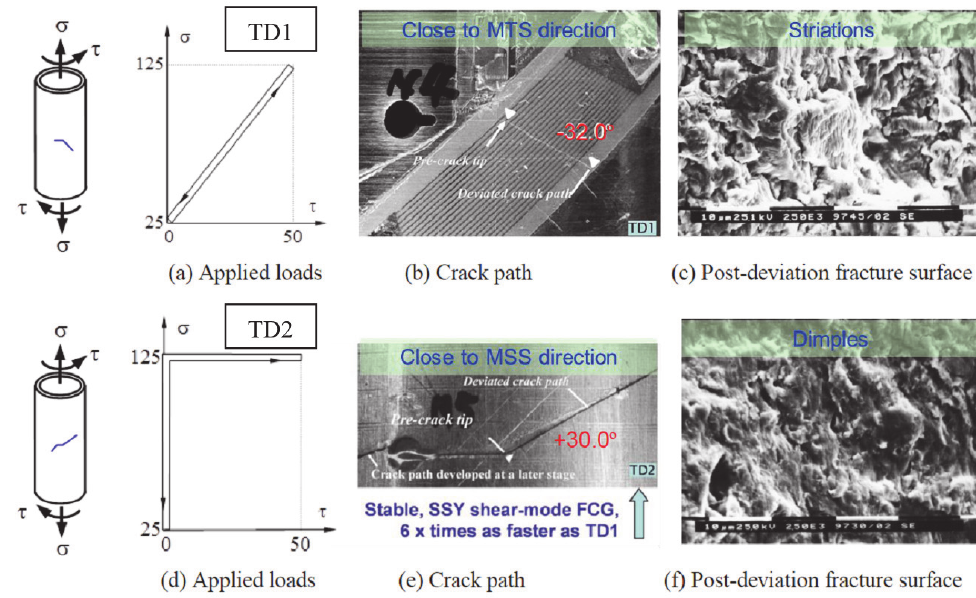
Figure 1: FCG from a mode I pre-crack, under proportional (a-c), and non-proportional (d-f), mixed-mode loads [3, 12]. (SSY in the figure refers to small scale